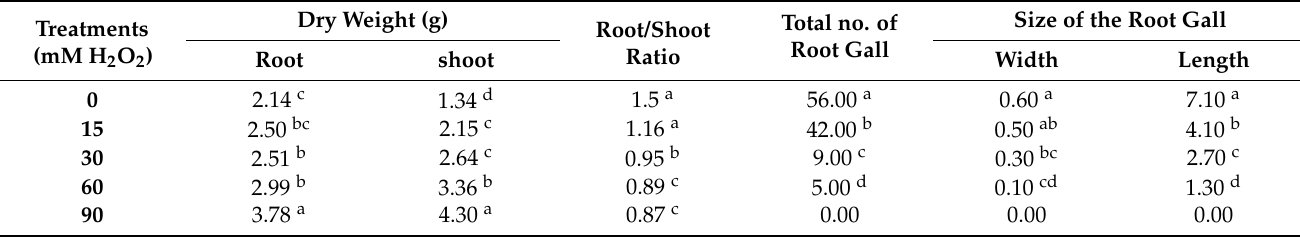
Table 6. Effects of different concentrations of H 2 O 2 on the weights of roots and shoots, number of root galls, and root gall size of F. deltoidea